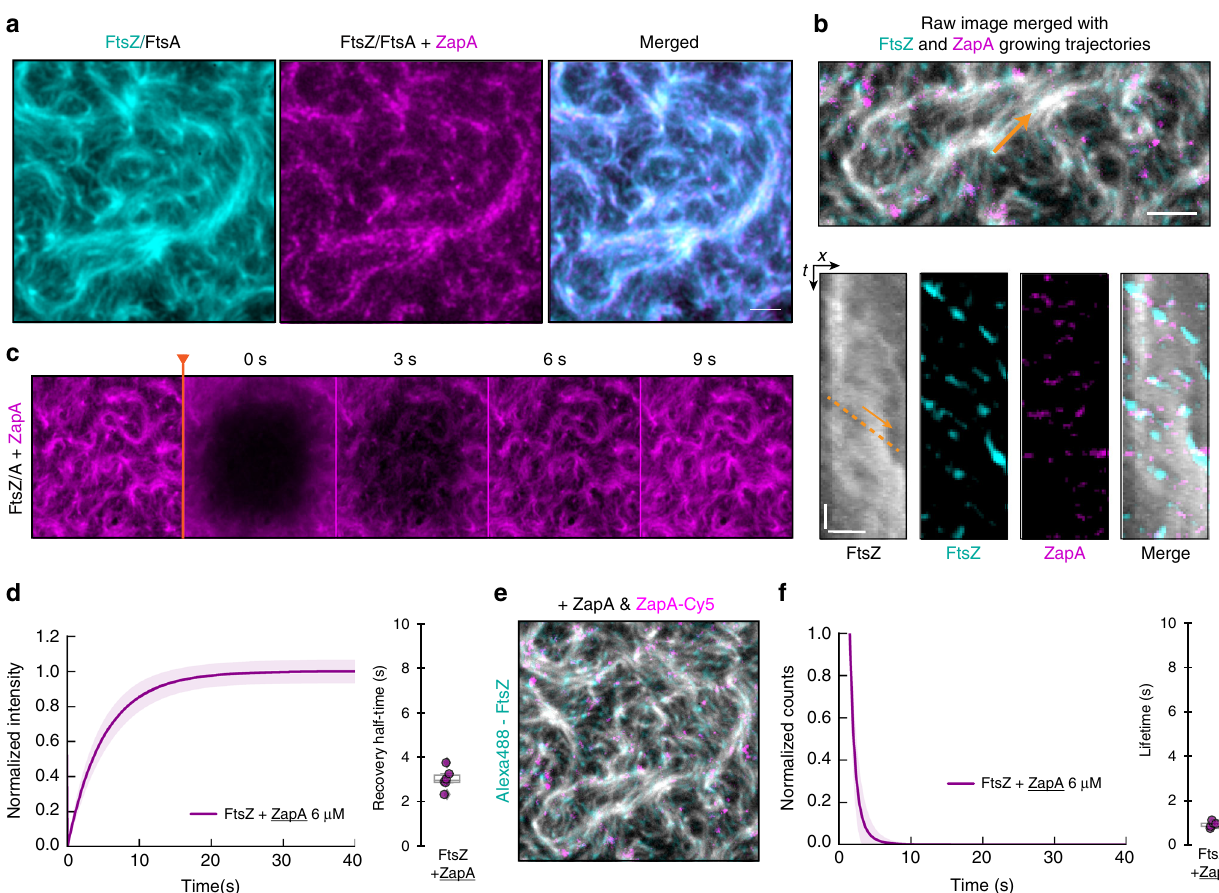
Fig. 7 ZapA binds only transiently to FtsZ fi laments. a Dual-color TIRF micrograph showing co-localization of Alexa488-FtsZ (cyan) and ZapA-Cy5 (magenta). b Raw image of FtsZ fi lament network overlaid with growing trajectories of FtsZ (cyan) and ZapA (magenta) from differential imaging (scale bar 5 μ m). Kymographs are obtained along the orange arrow, which indicates treadmilling direction. Scale bars, t = 20 s, x = 3 μ m. c Snapshots showing FRAP experiments of Cy5-labelled ZapA pattern. d Half-time recovery of Cy5-labelled ZapA showed a much faster recovery (ZapA = 3.01 ± 0.47, n = 6) when compared with FtsZ (Fig. 6b). e In contrast with FtsZ (Fig. 4d), the lifetime of ZapA was much shorter (ZapA = 0.95 ± 0.14, n = 5). Source data available at Figshare [https://doi.org/10.6084/m9. fi